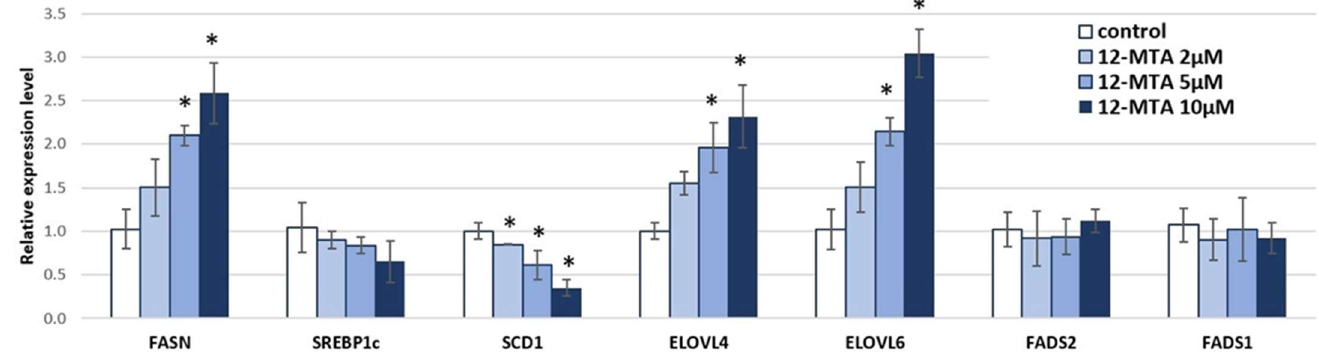
Figure 1. Relative expression level of selected genes involved in fatty acid synthesis and metabolism in visceral adipocytes incubated for 48 h in different concentrations of 12-methyltetradecanoic (12-MTA). Data are presented as mean ± SD. * p < 0.05 compared to control. FASN —fatty acid synthase; SREBP1 —sterol regulatory element-binding protein 1; SCD1 —stearoyl-CoA desaturase; ELOVL4 —fatty acid elongase 4; ELOVL6 —fatty acid elongase 6; FADS2 —fatty acid desaturase 2; FADS1 —fatty acid desaturase 1.